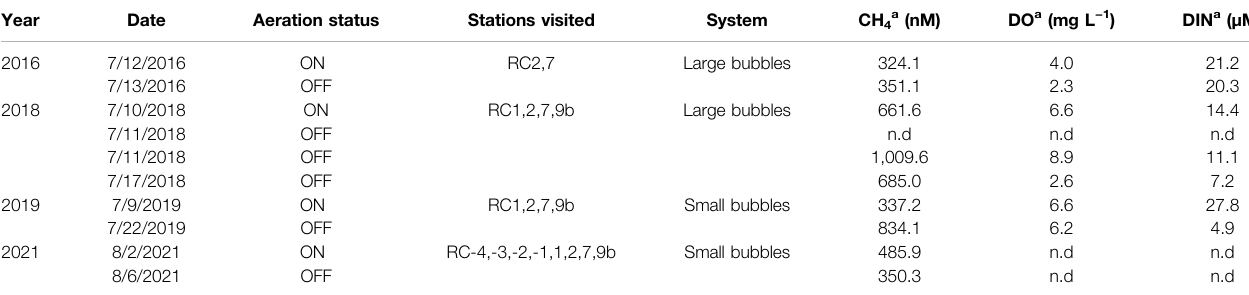
TABLE 2 | Overview of manipulation